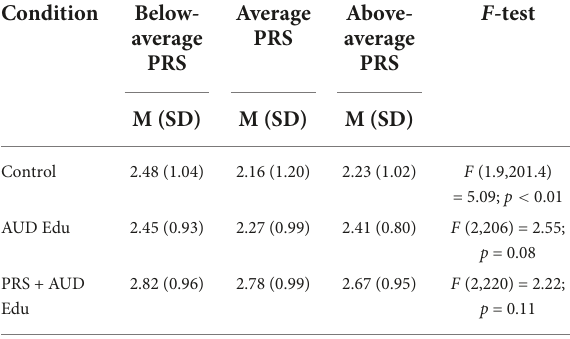
TABLE 5 Mean (SD) understanding of each level of hypothetical polygenic risk score for alcohol use disorder.